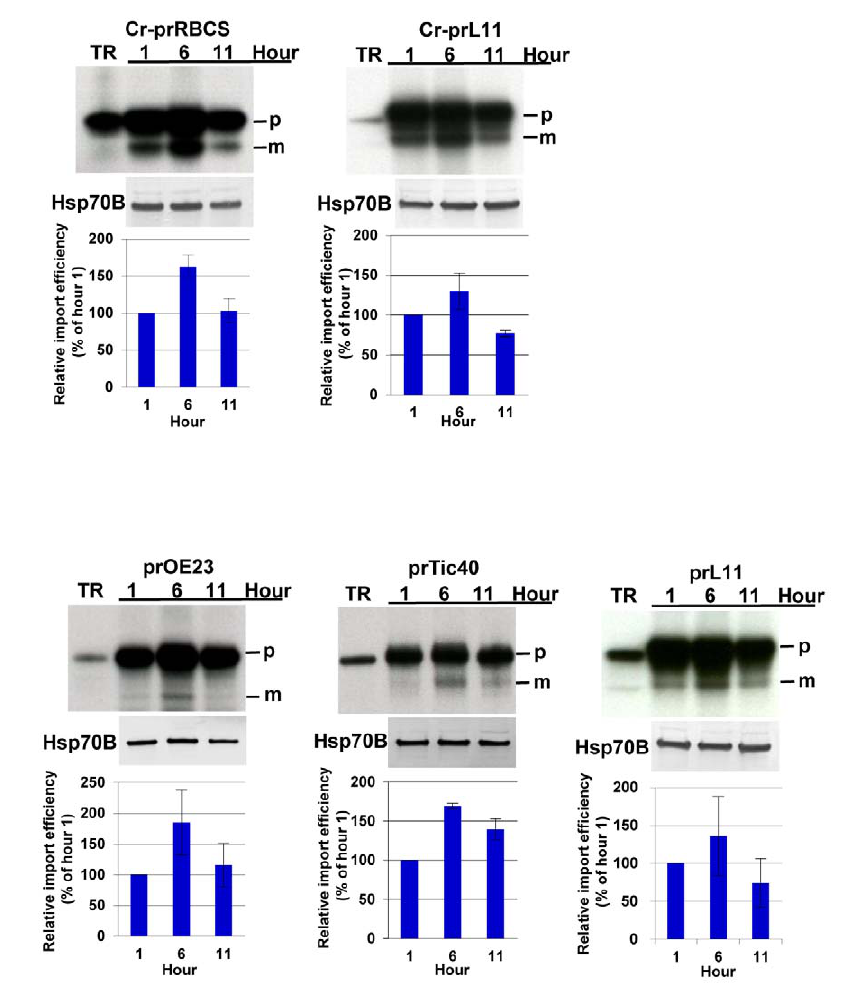
Figure 5. Protein import into Chlamydomonas chloroplasts is not differentially regulated. [ 35 S]Met-labeled precursors of Cr-prRBCS, Cr- prL11, prOE23, prTic40, and prL11 were imported into chloroplasts isolated from synchronized cultures of Chlamydomonas 1, 6, and 11 h after the start of the third light cycle and used for import experiments. Samples were analyzed by SDS-PAGE and autoradiography. An equal number of chloroplasts were loaded in each lane of the same gel. The amount of Chlamydomonas chloroplast Hsp70B was analyzed by immunoblotting and used for normalization of quantifications in the bar graph shown below each gel. The amount of mature protein imported at hour 1 was set as 100%. Data shown are mean 6 SD, n =3. m, mature form; p, precursor form; TR, in vitro–translated precursor proteins before